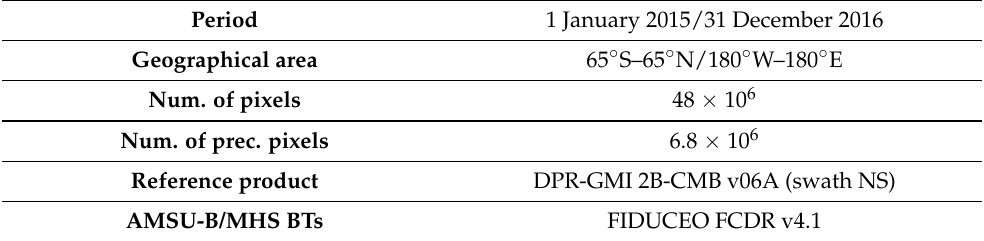
Table 4. Characteristics of the AMSU-B/MHS-DPR coincidence